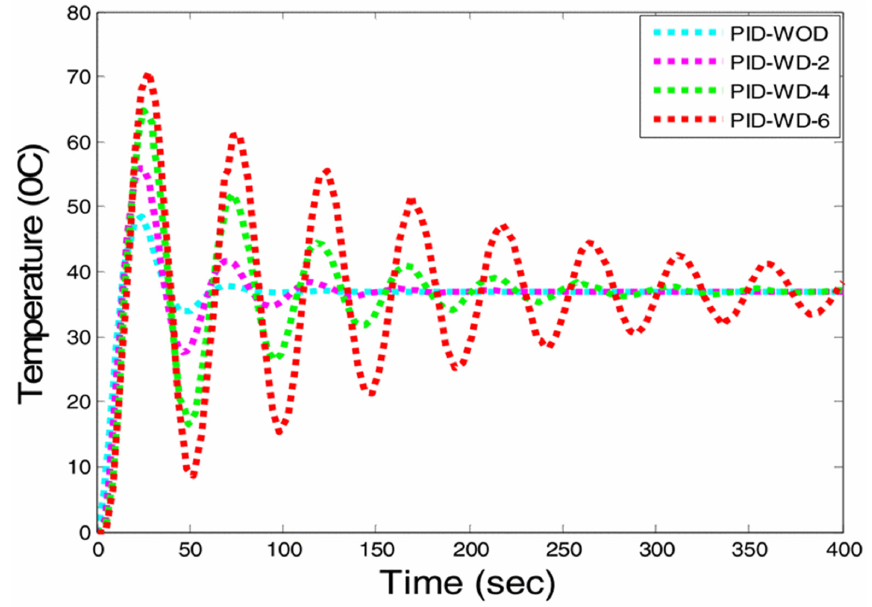
Figure 7. Ambulance output comparison plot of PID controller in terms of time and temperature.